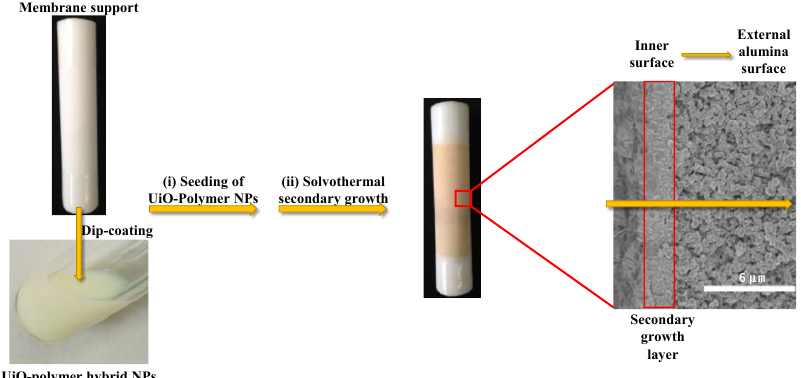
Scheme 1. Scheme of the dip-coating and secondary growth procedure for UiO-66-NH 2 membranes.